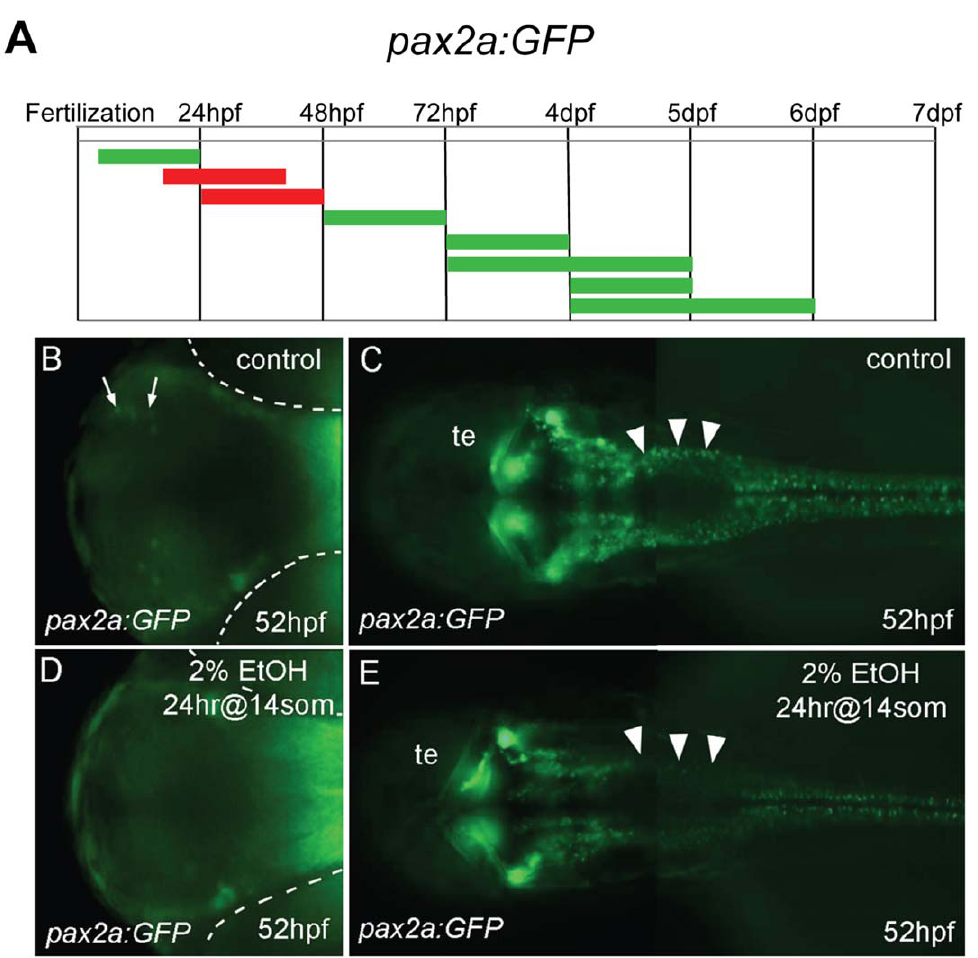
Figure 3. Forebrain and hindbrain pax2a:GFP positive cells are sensitive to ethanol exposure. A , the duration and embryonic stage of 2% ethanol treatments illustrated with colored bars for Tg(pax2a:GFP) embryos, as described in Fig. 1. B 2 E , ventral views (B, D) and dorsal views (C, E) of Tg(pax2a:GFP) embryos at 52 hpf. B, C , are controls. D, E , were treated with 2% ethanol for 24 hrs at the 14 somite stage. B, D , a small, distinct group of neurons in the forebrain (arrows in B) were missing after ethanol exposure (D). The location of the eyes is outlined (dashed white lines). C, E , neurons around the midbrain-hindbrain region were mostly unaffected, hindbrain neurons were drastically reduced (arrowheads), and spinal cord neurons appeared slightly reduced. Tectum (te).